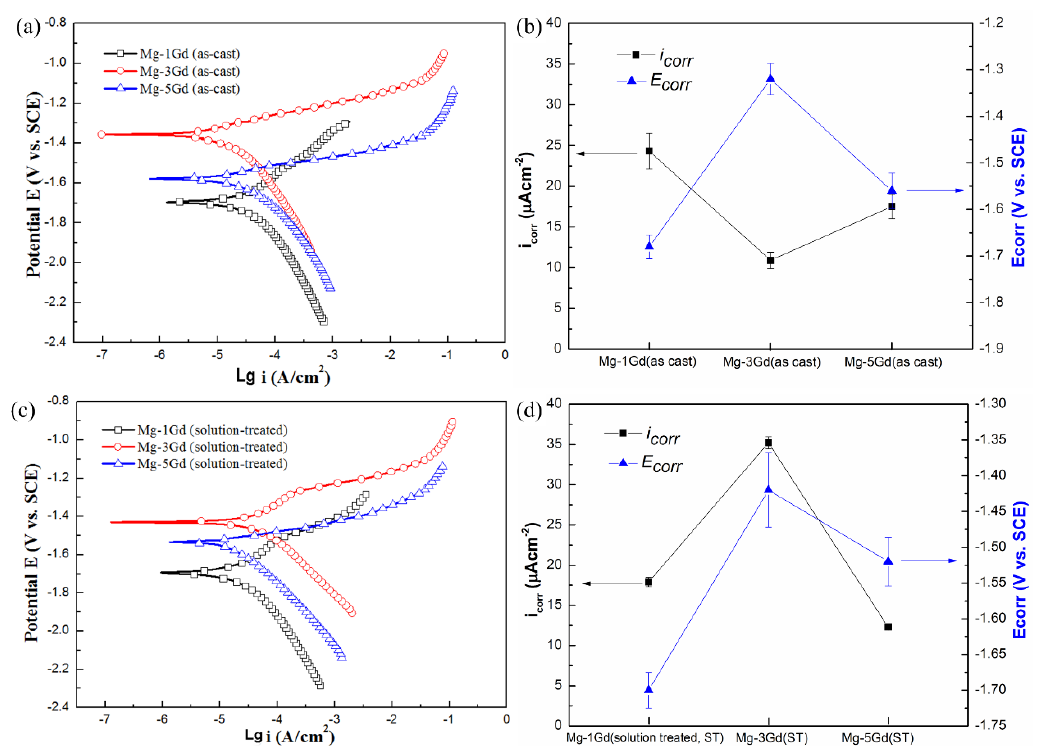
Figure 11. Potentiodynamic polarization curves and corrosion characteristics of different Mg-xGd alloys tested in 37 °C Hanks’ solutions: ( a ) and ( b ) as-cast and ( c ) and ( d ) solution-treated.